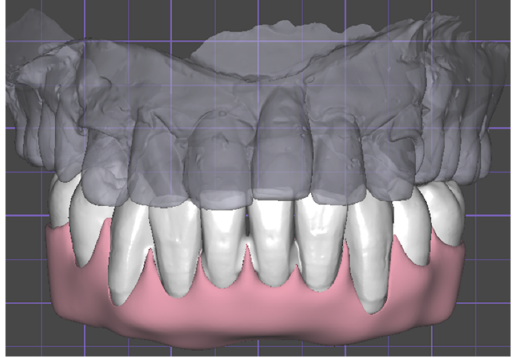
Figure 3. Digital projection of the provisional prosthesis.